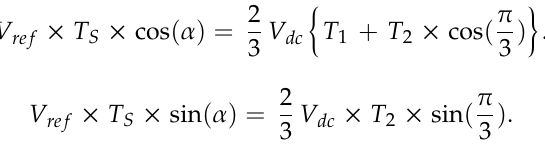
Figure 6. Gating sequence for the switches.